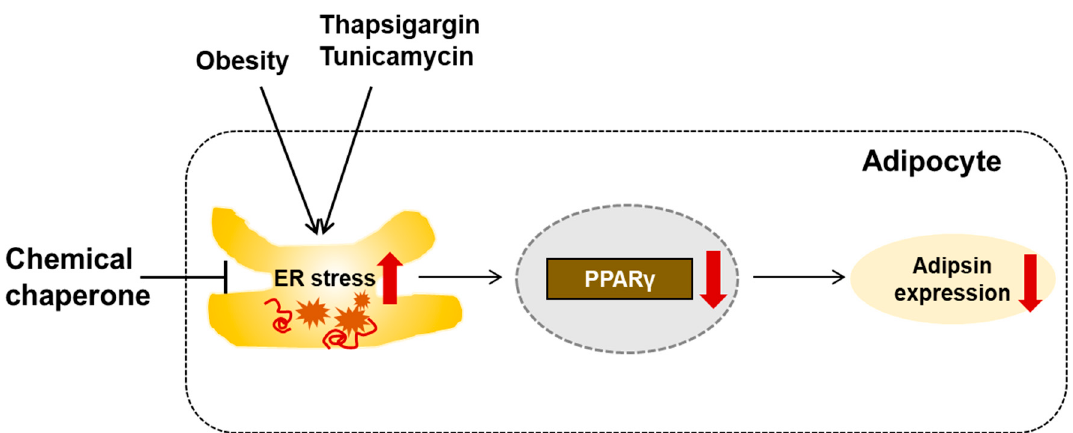
Figure 8. A graphical representation of the results of the present study. Activated ER stress induced by obesity or ER stress inducers (thapsigargin or tunicamycin) reduces adipsin expression, presumably through downregulation of PPAR γ in adipocytes. Suppression of ER stress by a chemical chaperone can restore adipsin expression.